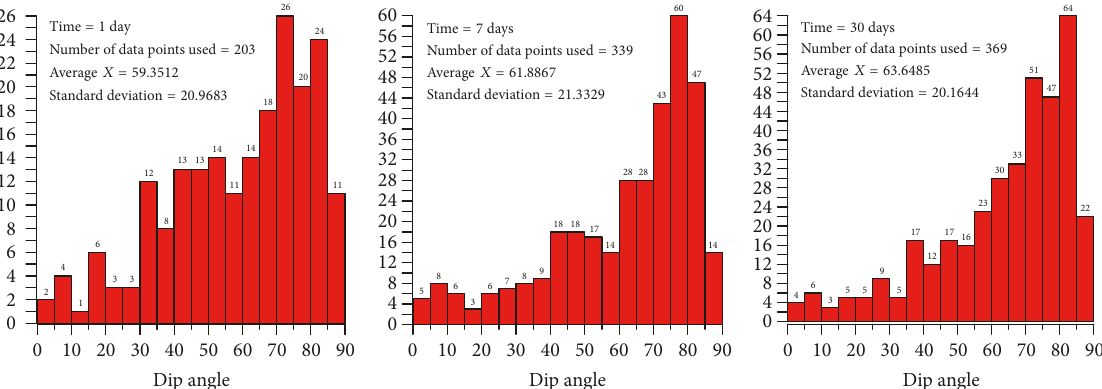
Figure 38: Histograms of the Frac-Digger sensitivity of the estimated dip angles of dikes to the time difference ( 𝛿𝑡 ) allocated to the plane- oriented cluster.